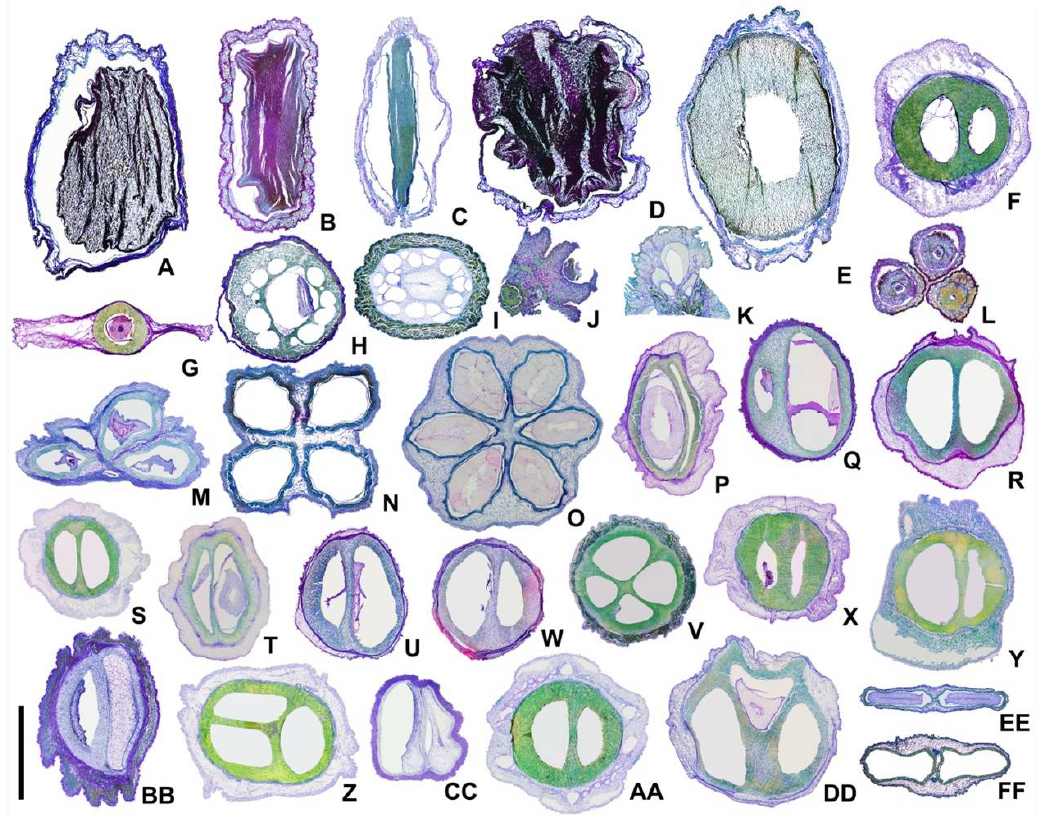
Figure 3. Transverse sections of fruit structures. ( A ) Aucuba chinensis var. angusta; ( B ) A. chinensis;